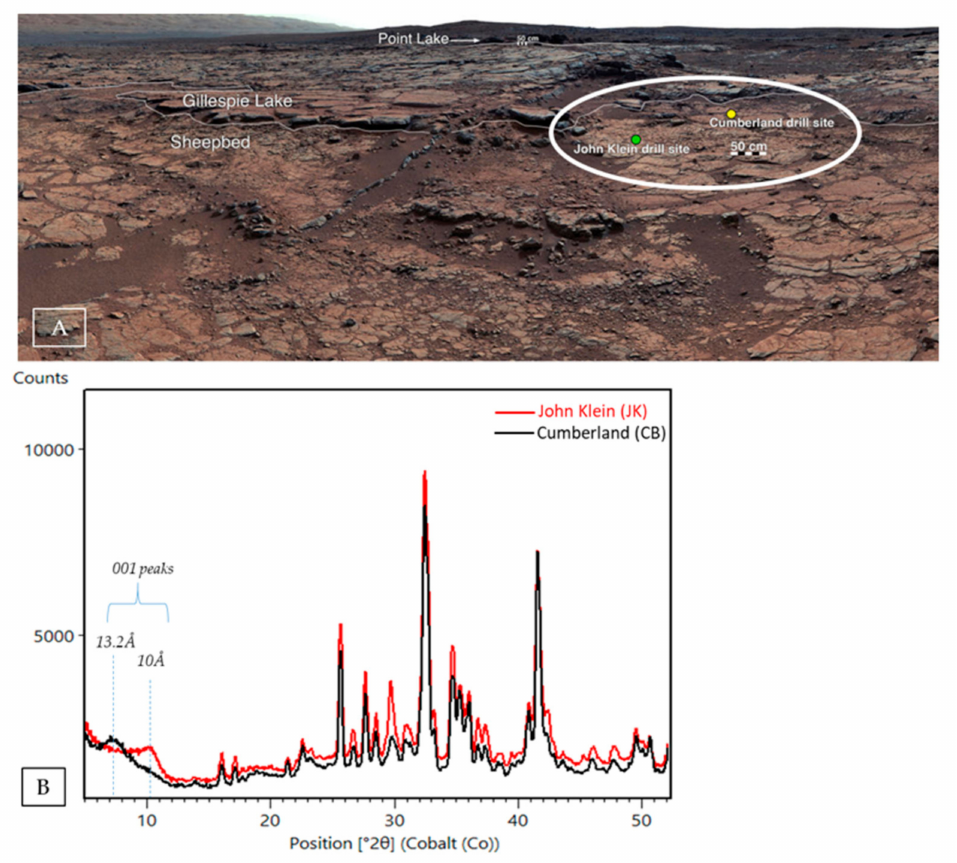
Figure 9. ( A ) Mastcam mosaic of Yellowknife Bay showing the drill sites of John Klein and Cumber- land. ( B ) CheMin X-ray diffraction patterns of the Cumberland (black) with a basal 001 d-spacing of 13.2 Å and John Klein (red) drill samples, with a basal 001 d-spacing of 10 Å.